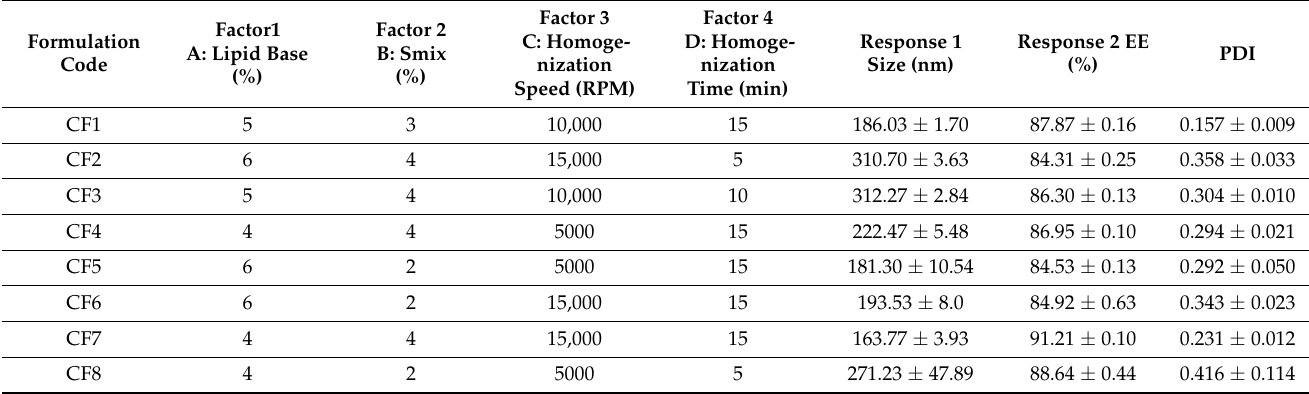
Table 2. Experimental trails executed using CCD with respective